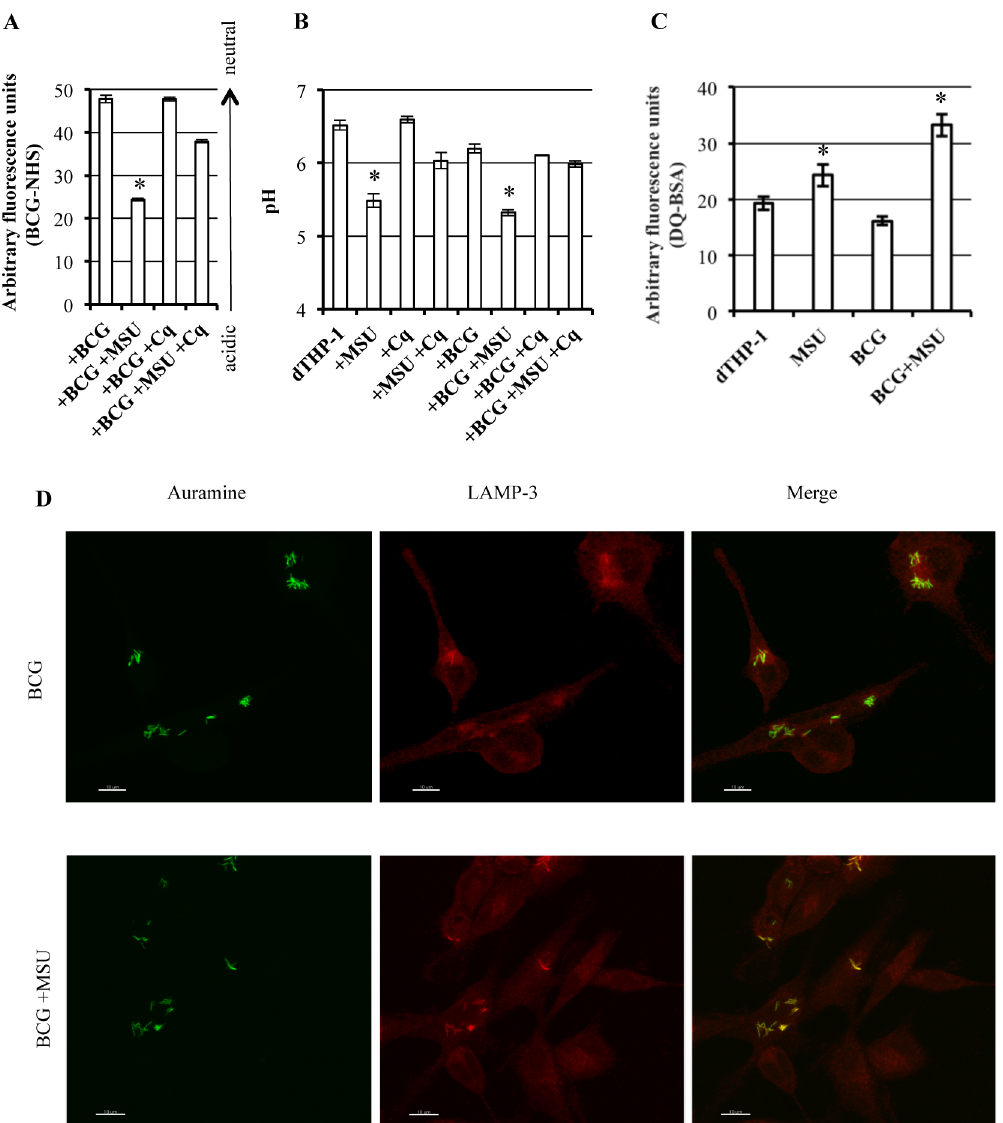
Fig 3. MSU crystals promote maturation of phagosomes containing BCG. ( A ) dTHP-1 cells were infected with NHS labelled BCG at the MOI of 1 and then stimulated overnight with 5 μ g/ml of MSU, in the presence or absence 10 μ M Chloroquine. Results are expressed in terms of mean ± SD of arbitrary fluorescence units of triplicate values and are representative of two independent experiments. * p < 0.001 in comparison with non-stimulated control cells, ° p < 0.001 in comparison with MSU stimulated cells. ( B ) dTHP-1 cells were infected with BCG, stimulated overnight with 5 μ g/ml of MSU, in the presence or absence of 10 μ M Chloroquine (Cq), and then labelled with 1 μ M Lysosensor green DND 189. Results are expressed as mean ± SD of pH values from cultures performed in triplicate and are representative of two independent experiments. * p < 0.001 in comparison with non-stimulated control cells, ° p < 0.001 in comparison with BCG infected MSU stimulated cells ( C ) Protease activity of BCG infected dTHP-1 cells stimulated overnight with 5 μ g/ml of MSU was analysed by loading of 10 μ g/ml DQ red BSA for 2h at 37°C. Results are expressed as mean ± SD of triplicate values and are representative of three independent experiments. * p (cid:3) 0.01 in comparison with non-stimulated control cells. ( D ) Confocal microscopy representative images out of 10 per condition showing the increase of Auramine-stained BCG (green) residing in LAMP-3 positive vacuoles (red) after stimulation with 5 μ g/ml of MSU. One representative experiment out of three is shown. ( E ) Summary of the mean percentage ± standard deviation (SD) of BCG co-localizing in LAMP-3-positive vacuoles determined by acquiring at least 10 images per condition and by counting (cid:4) 50 dTHP-1 cells per sample, after stimulation or not with MSU. Three different experiments were assessed. * p < 0.05 in comparison with BCG-infected cells (data were analyzed using the unpaired Student ’ s t -test).